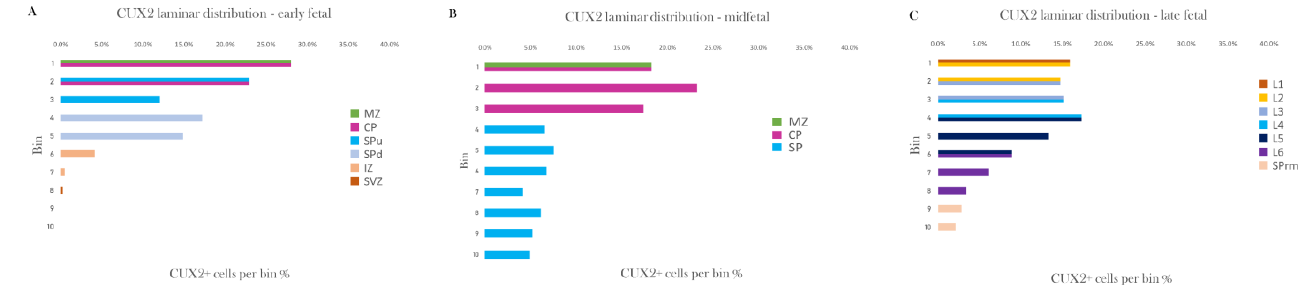
Figure 10. CUX2 laminar distribution presented as a percentage of CUX2 positive cells in the cortical compartments throughout the development. ( A–C ) Cortical surface area of coronal sections was segregated into ten bins, which were delineated into the actual compartments where CUX2 was expressed, by comparison to the adjacent Nissl section (MZ, CP, SPu, SPd, IZ, SVZ during early fetal period; MZ, CP, SP during the midgestation; L1–L6, SPrm during late fetal period).